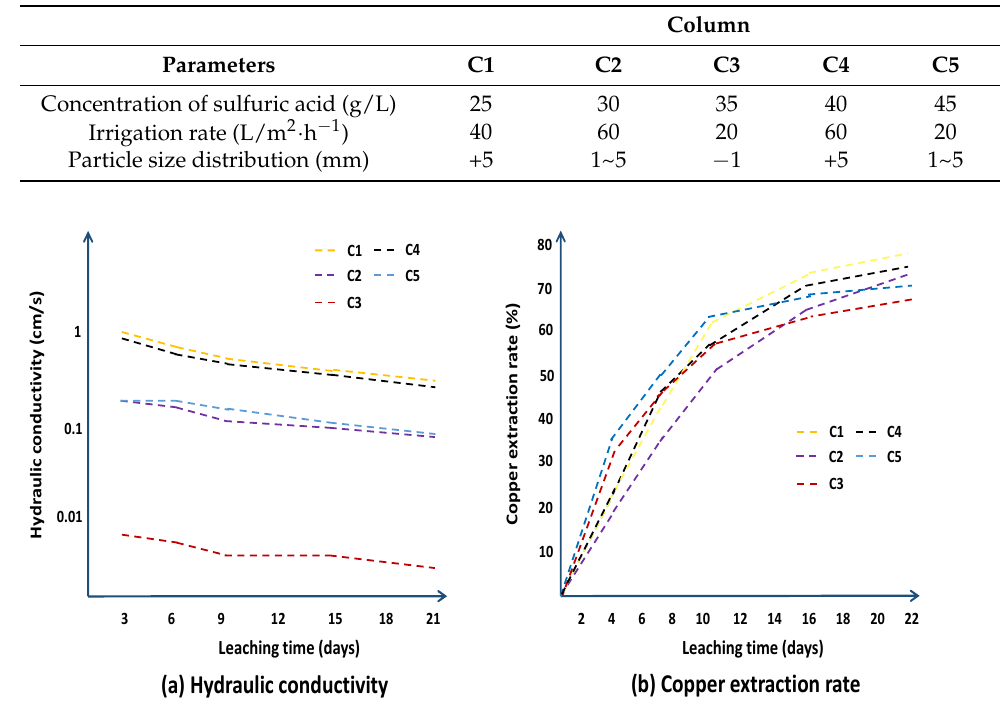
Figure 8. Critical permeability and leaching parameters with leaching time in different groups (Modified from [80]), ( a ) Hydraulic conductivity, ( b ) Copper extraction rate.